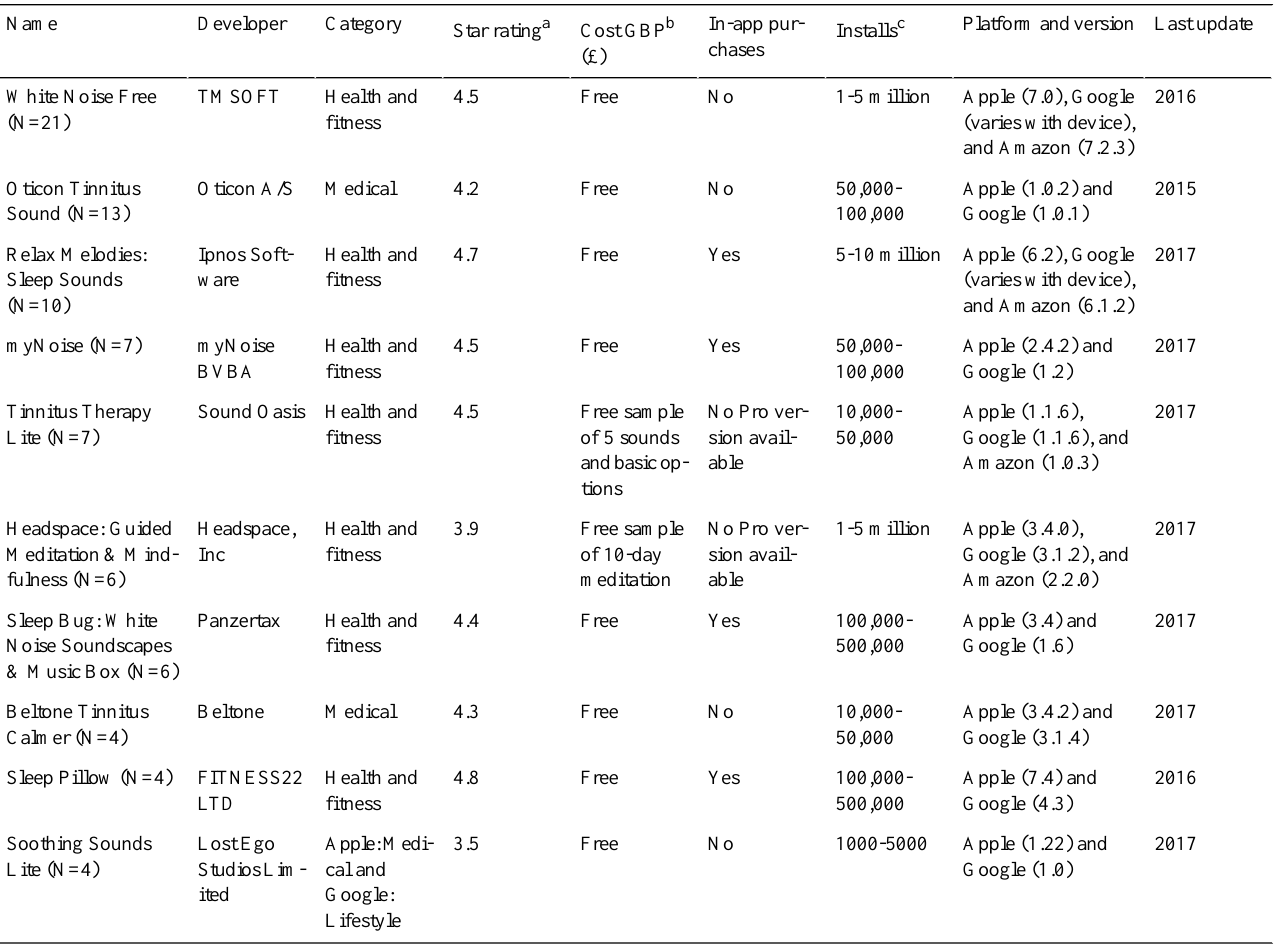
Table 1. Characteristics of the apps mentioned by at least three respondents (N=number of times app was cited).